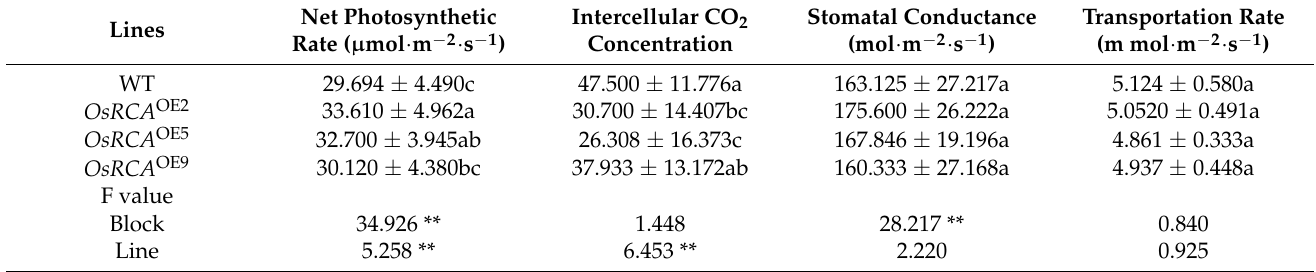
Table 1. Gas exchange parameters at the grain–filling stage and ANOVA of WT and OsRCA OE lines.